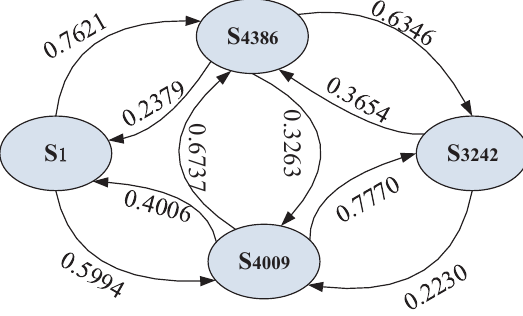
Figure 8. Case study of the markov